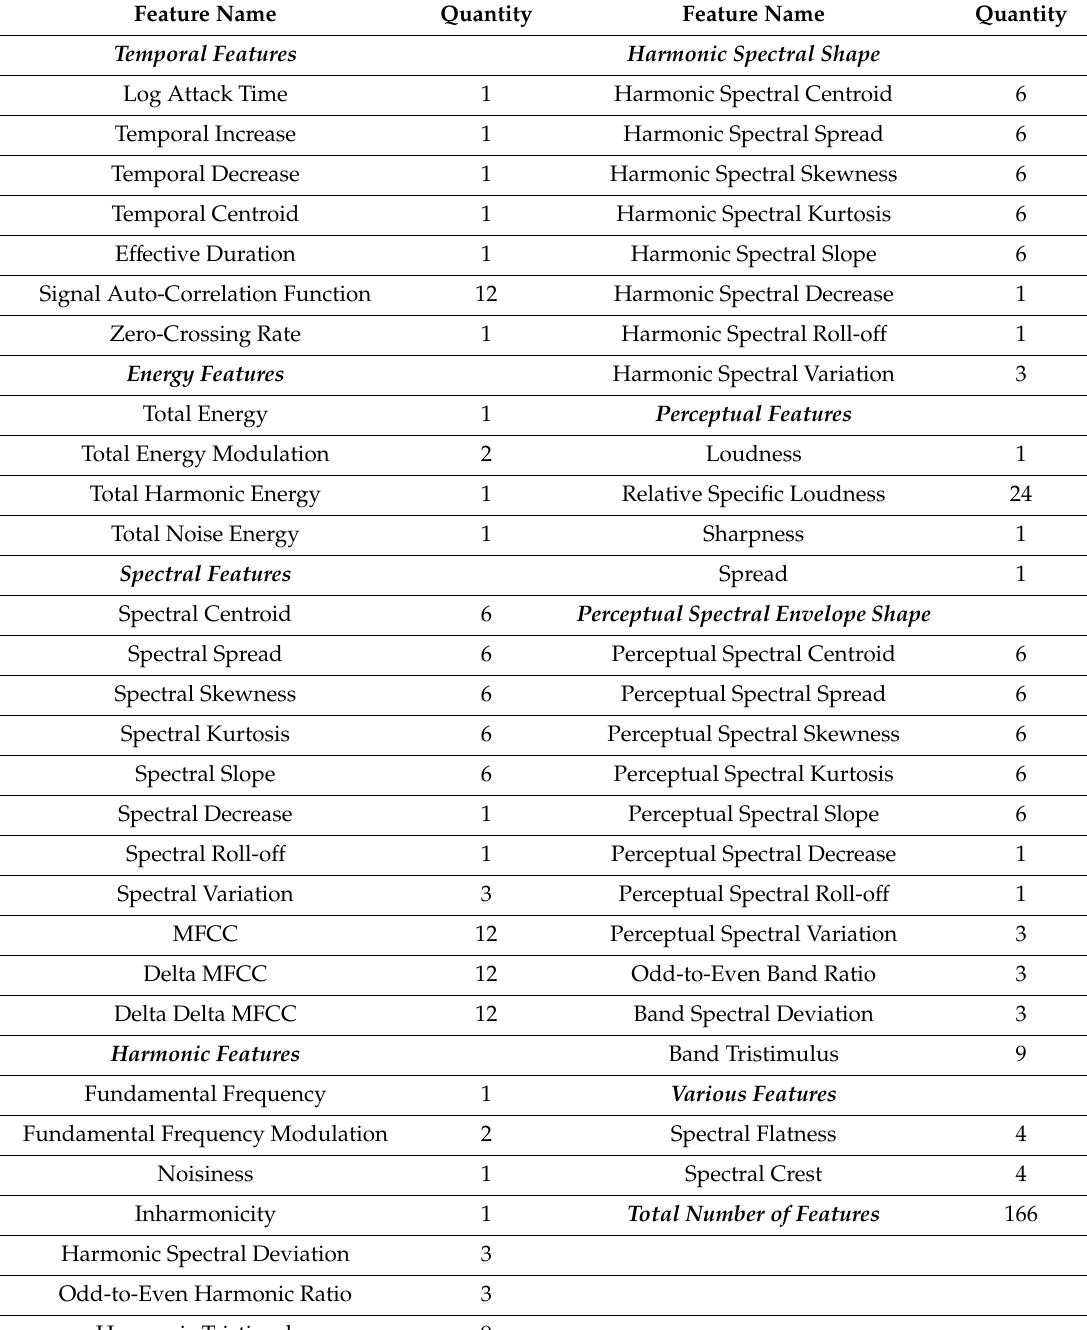
Table 6. Acoustic